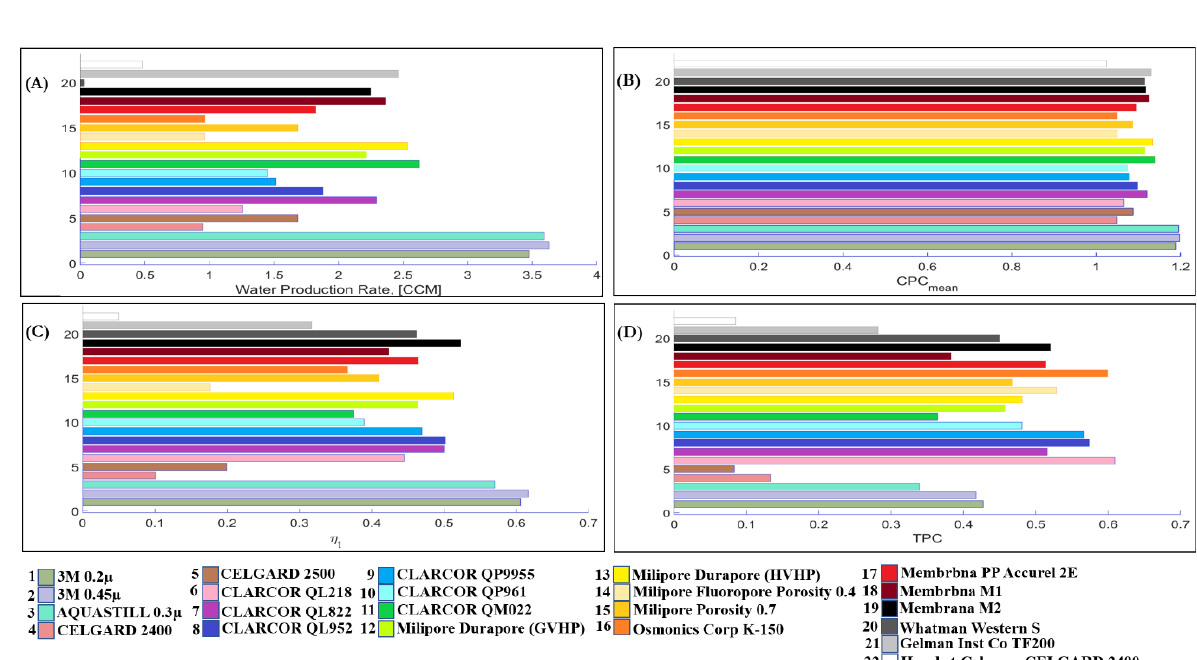
Figure 12. ( A ) Water production rate, ( B ) Maximum of CPC, ( C ) Thermal efficiency η t , and ( D ) TPC for the 22 commercially available membranes listed in Table 2.